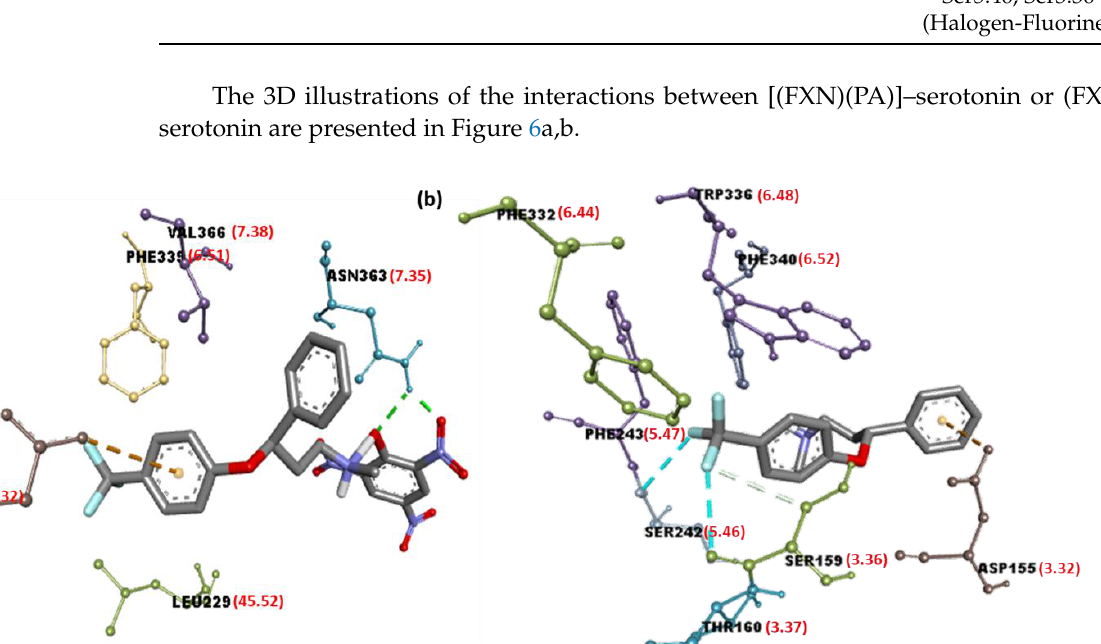
Figure 6. Three-dimensional illustrations of interactions of ( a ) [(FXN)(PA)] – serotonin and ( b ) (FXN) – serotonin, representing Ballesteros – Weinstein nomenclature in red brackets. As shown in Figure 6a, in the [(FXN)(PA)] – serotonin complex, the amino acid residue Asn363 is responsible for the hydrogen-bond interactions. Additionally, Val366 (7.38; Bal- lesteros – Weinstein nomenclature), Leu229 (45.52), Phe339 (6.51) (π -Alkyl), and Asp115